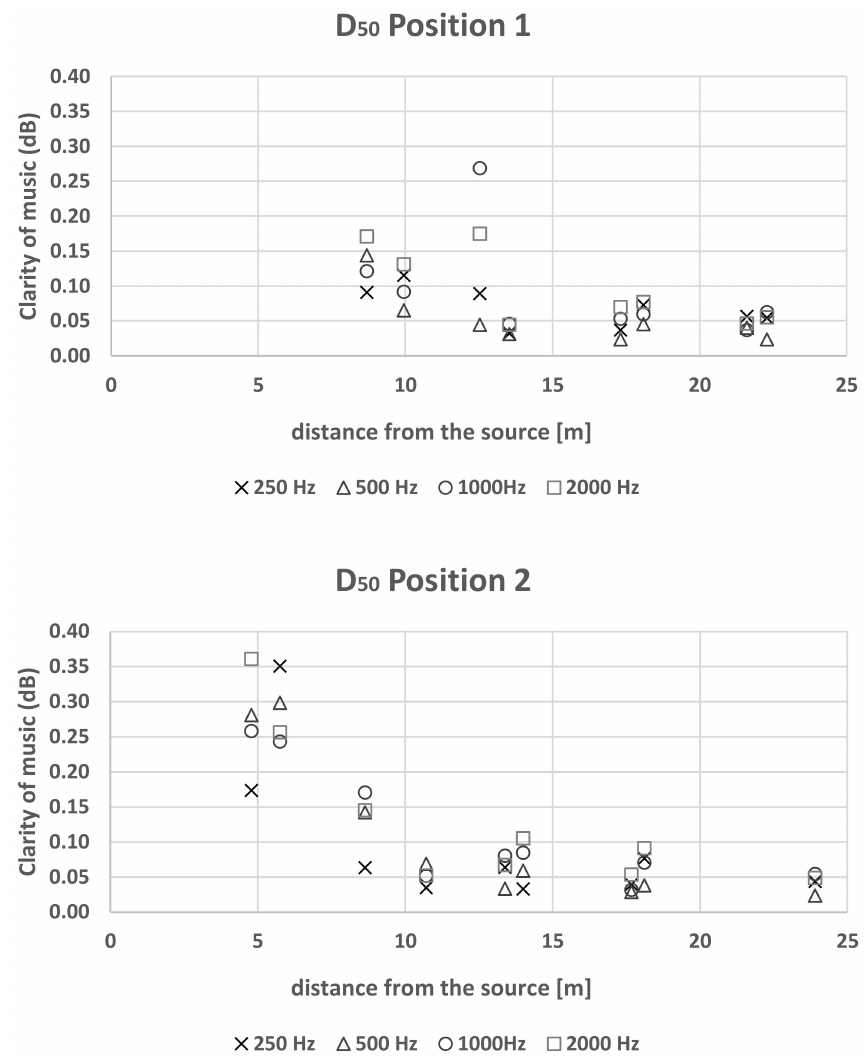
Figure 15. D 50 vs. distance from the source position 1 ( top ) and 2 ( bottom ). Table 4. The squared regression coefficient R 2 and type of best fit